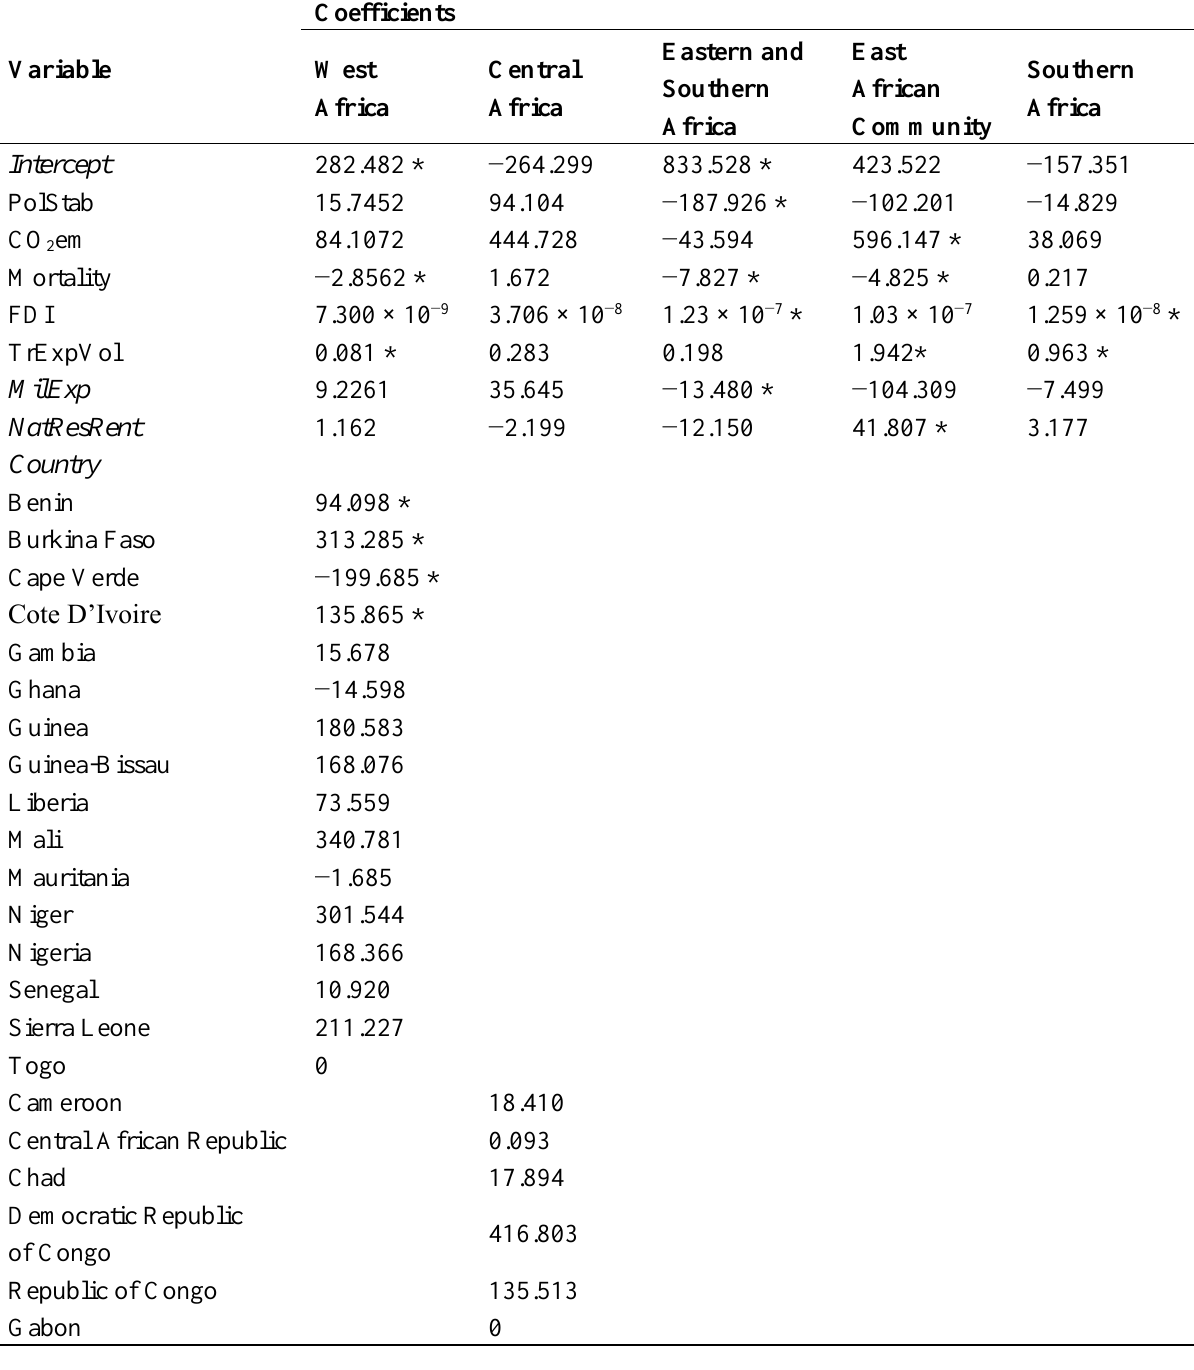
Table 3. Regressions by